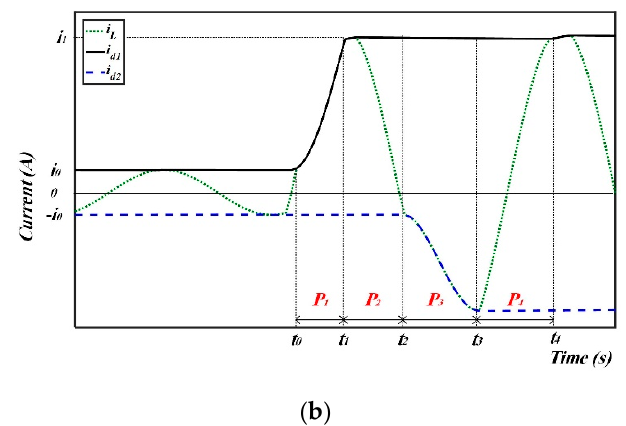
Figure 2. ( a ) Configuration of the single phase MCFCL under study, ( b ) MCFCL performance under normal and faulty conditions.